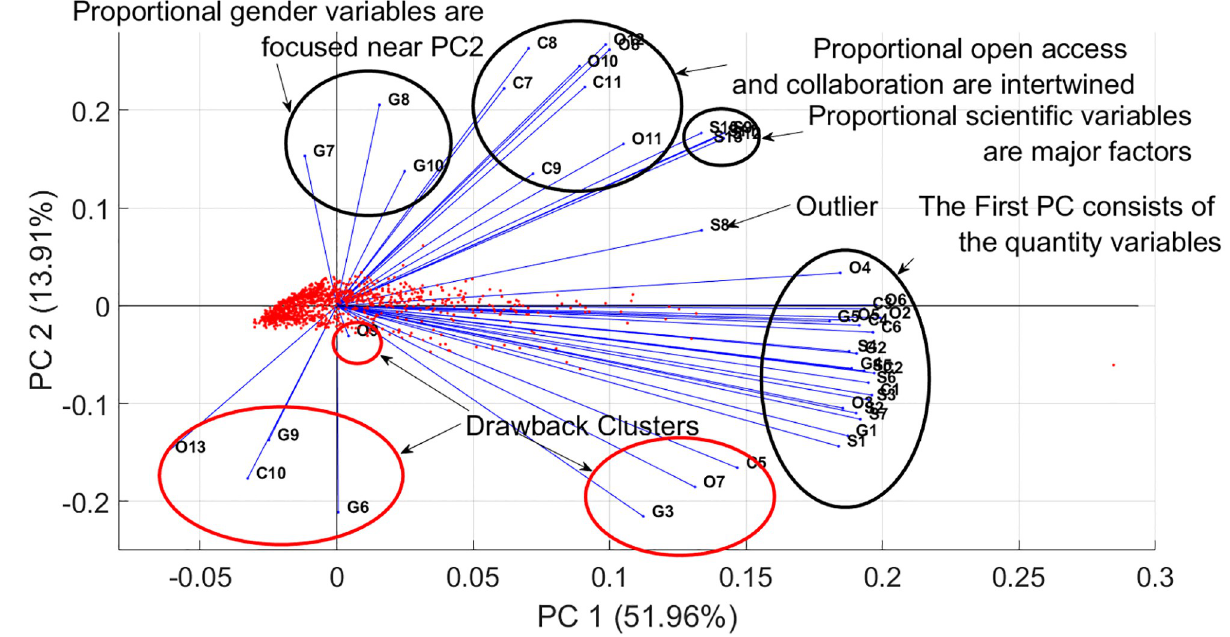
Fig 9. Relationship between objectives by PCA. The biplot depicts both scores and loadings, however, the scores are scaled differently in Fig 8. The axes split the objectives; the vertical axis distinguishes between the effects of the objectives that either impair or benefit the solutions, in this case, universities. In the fourth quarter, the objectives are quantity indicators, while in other quarters, the proportional indicators can be identified. Six clusters can be observed: three gender proportional indicators, the proportional variables of collaboration and open-access indicators, the proportional variables of scientific indicators, the quantity indicators, and the two drawback clusters. There is an outlier objective (S8). When a university improves their indicators in the drawback clusters, their performance decrease, moving the farther from the Pareto